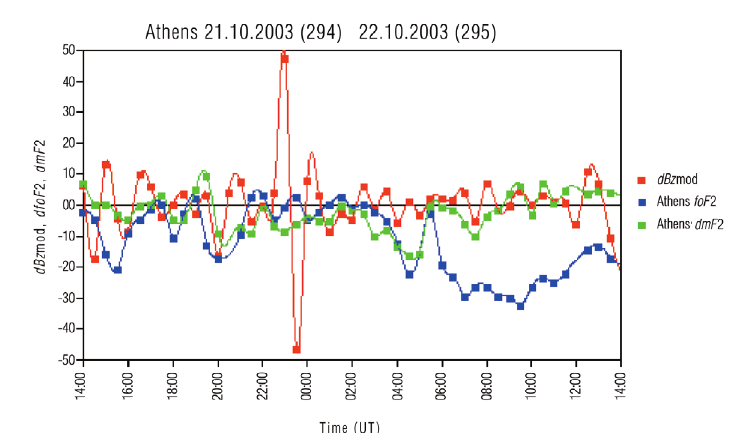
Fig. 11. Bz -IMF rate of change over the preceding 30 min interval, with the corresponding percentage devia- tion from the median of foF 2, dfoF 2 (%), and percentage deviation from the median of M (3000) F 2, dmF 2 (%), for Athens